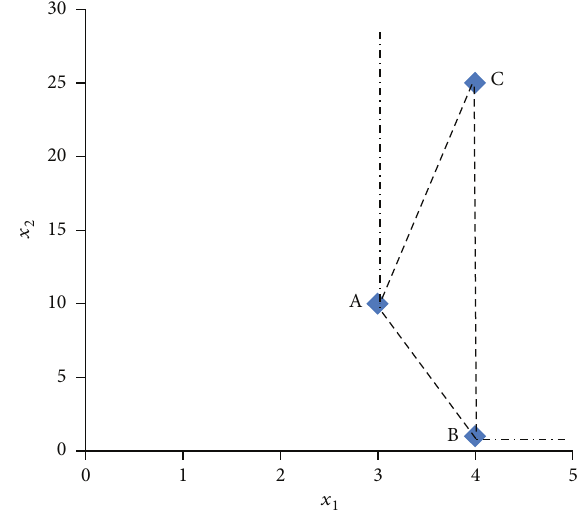
Figure 1: Feasible region bounded by 𝐿 and 𝑈 .